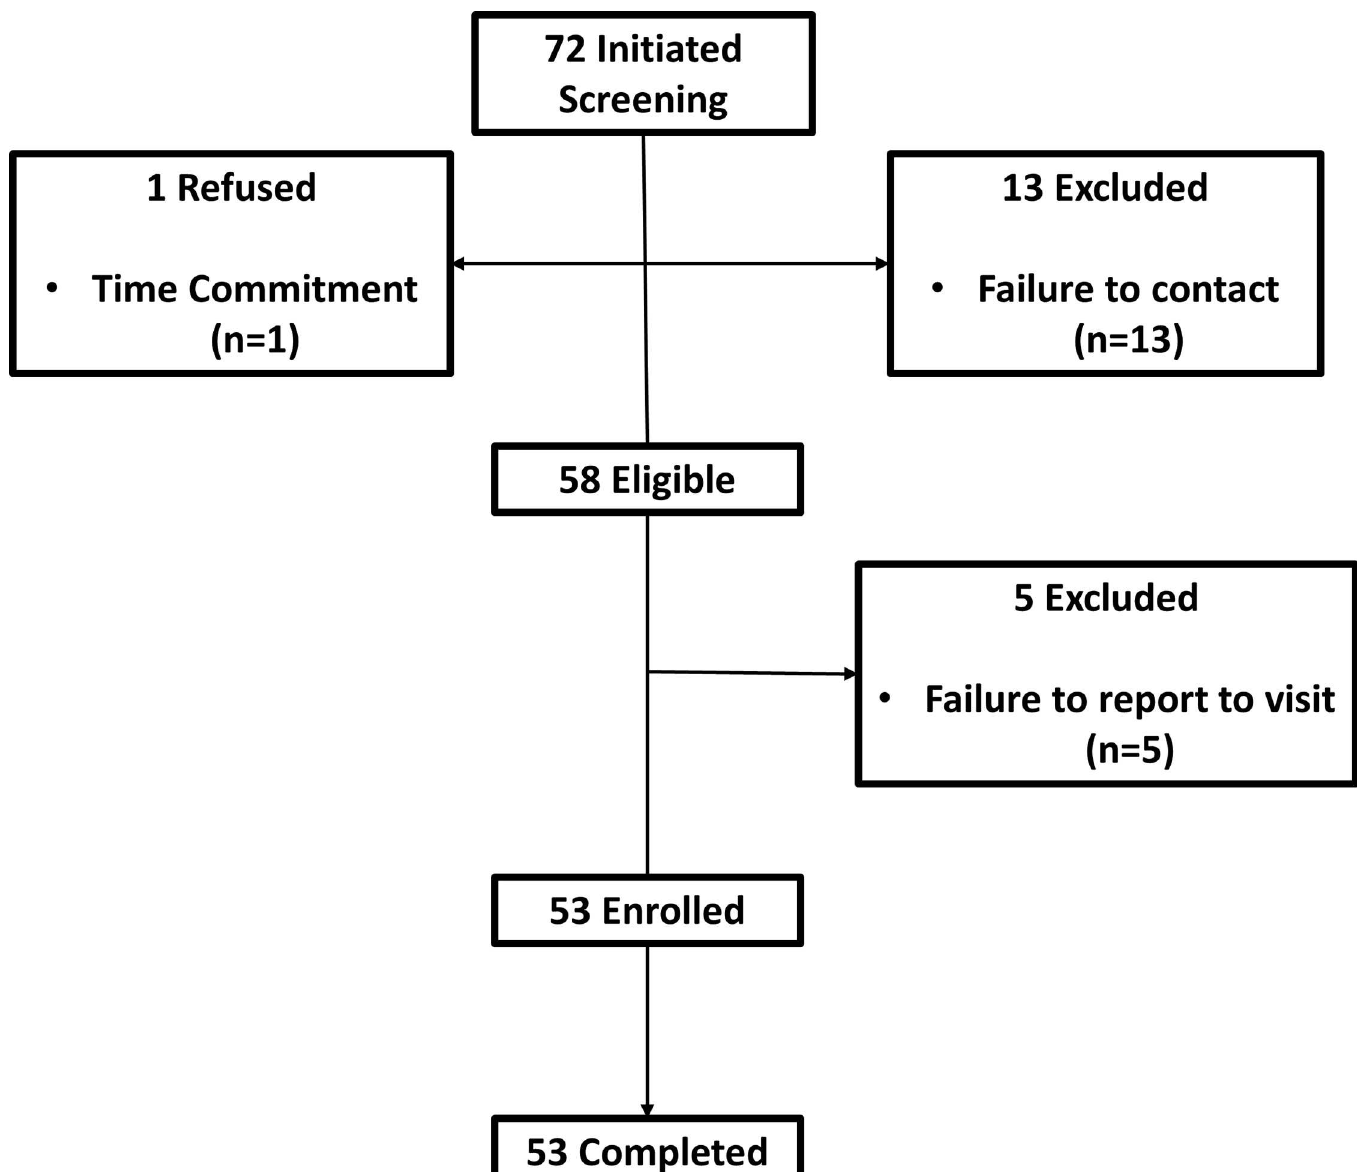
Fig 2. Consort Flow